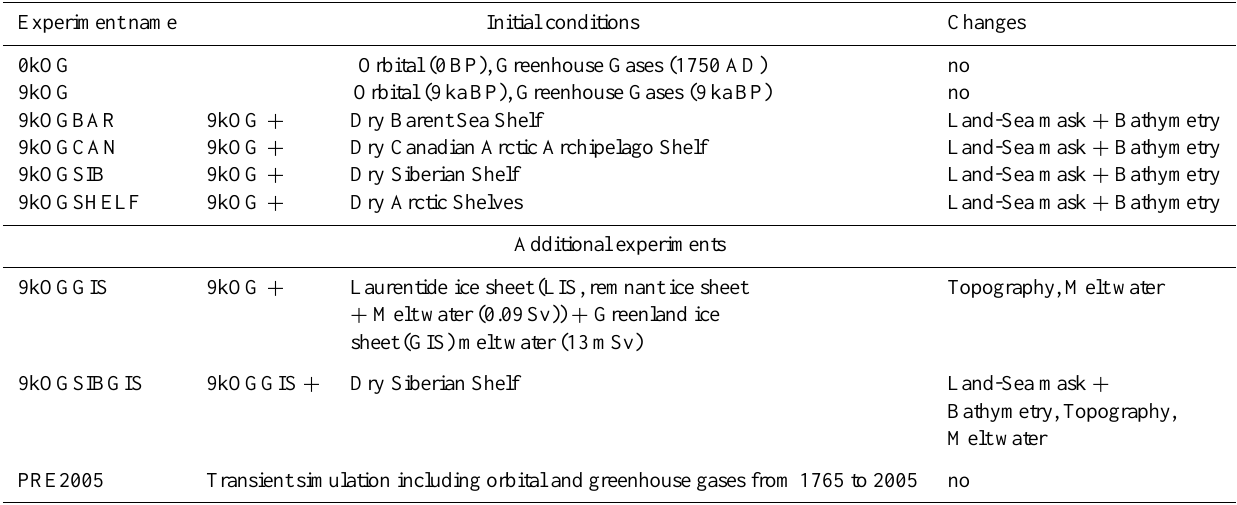
Table 1. Summary of experiments. Shelf areas according to Fig.